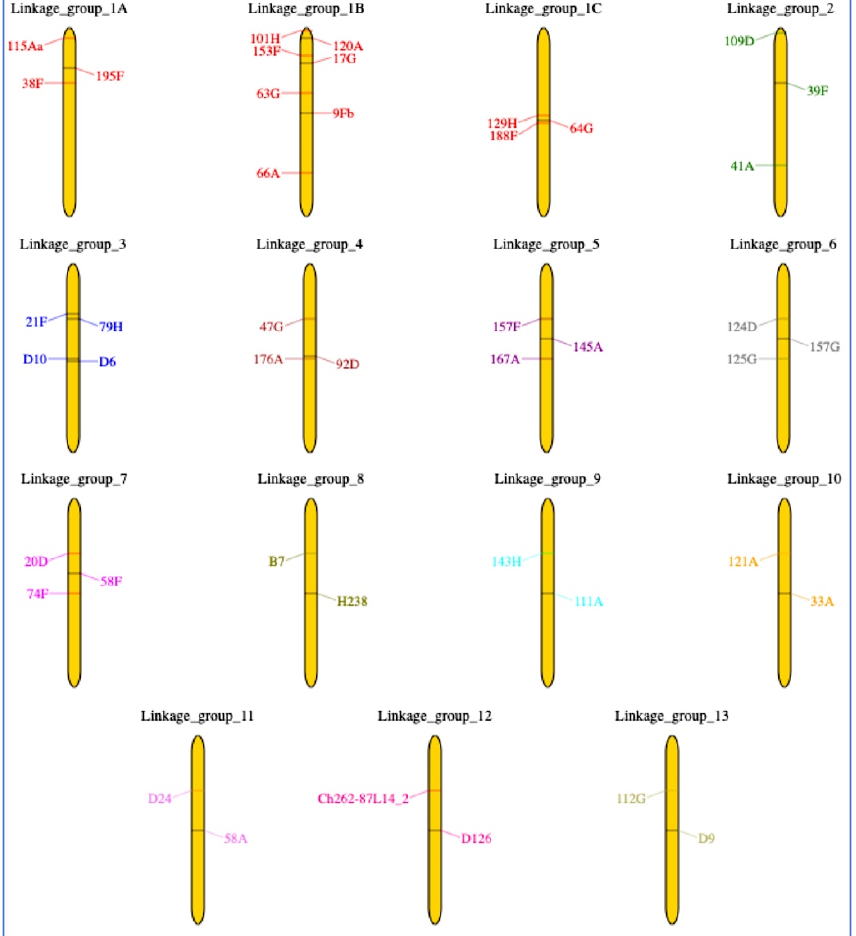
Figure 1. A first-generation California condor linkage map built using microsatellite loci. Length of linkage groups (LGs) and position of the loci are provisional, with a strong evidence of marker order being only available for subgroup 1A. Markers on the same LG are shown with the same colors. Table 2. A set of 18 polymorphic microsatellite markers chosen for paternity (parentage)